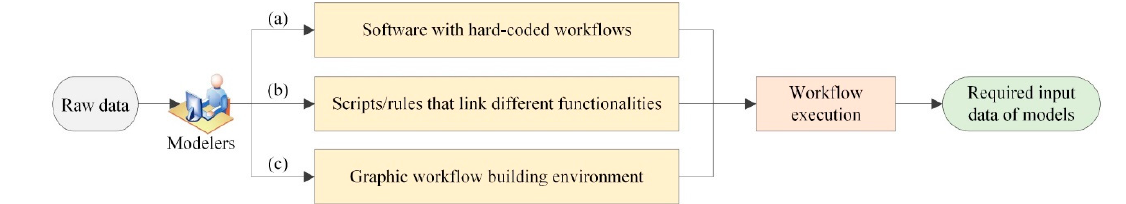
Figure 3. Three ways to automate the workflow building process.